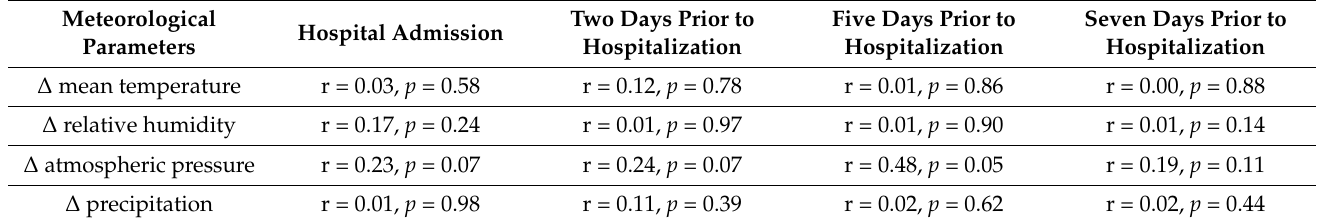
Table 1. Association of changes in meteorological parameters (mean temperature, relative humidity, atmospheric pressure, precipitation) and the occurrence of OA on the day of hospitalization and two, five, and seven days before